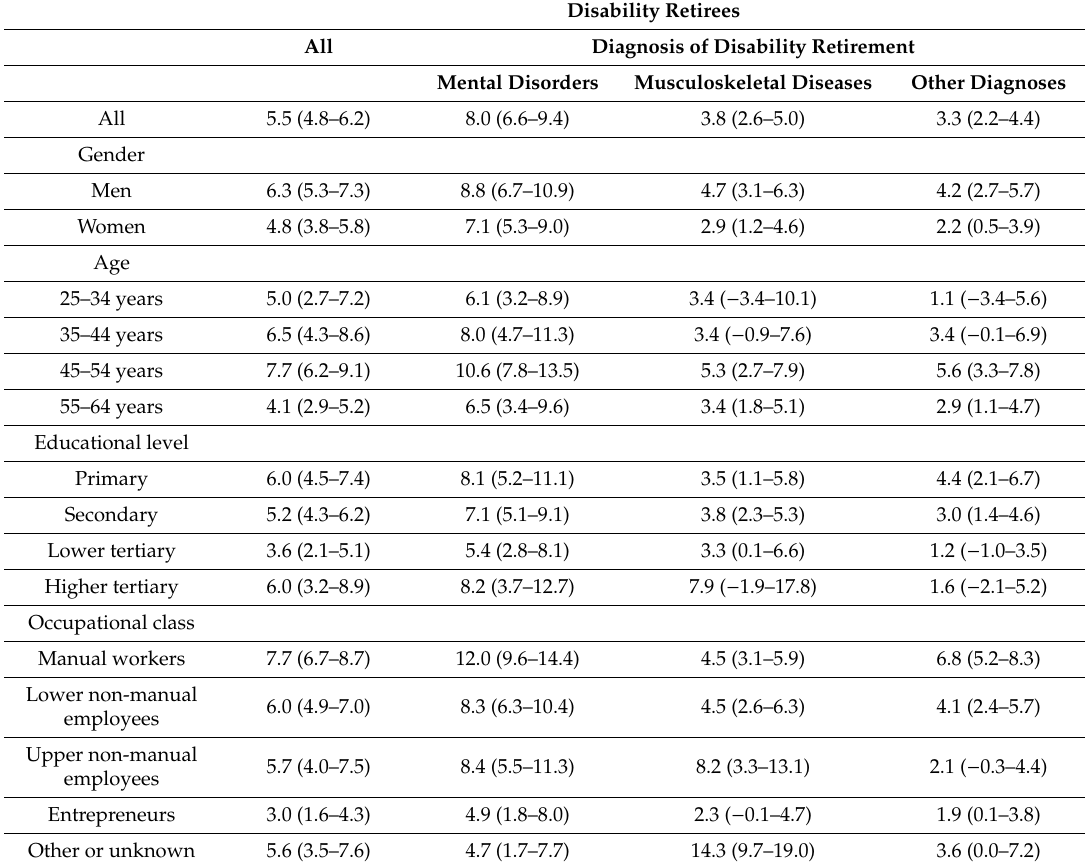
Table 4. Average increase in the number of unemployment days per one year during the years before disability retirement by the study variables (mean and 95% confidence intervals) adjusted for gender, age and calendar year. The last year before disability retirement